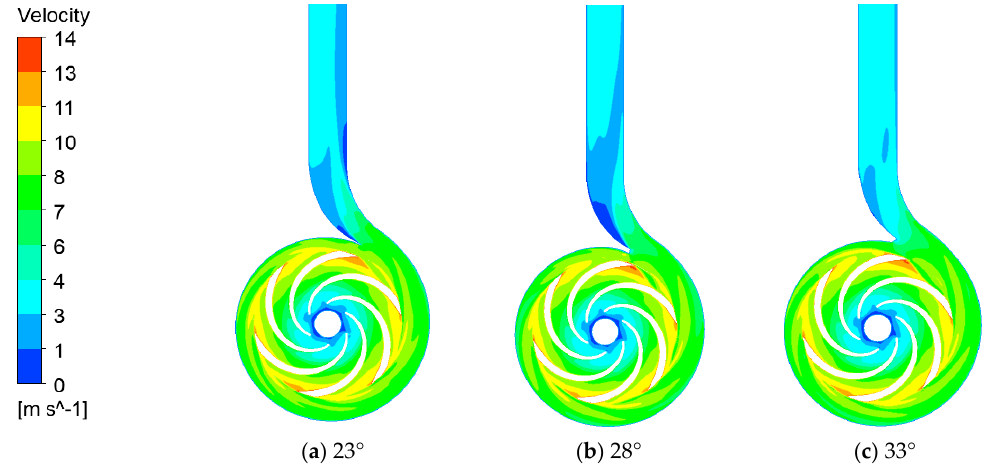
Figure 14. Velocity distribution on volute cross section under design flow rate condition with different volutes.